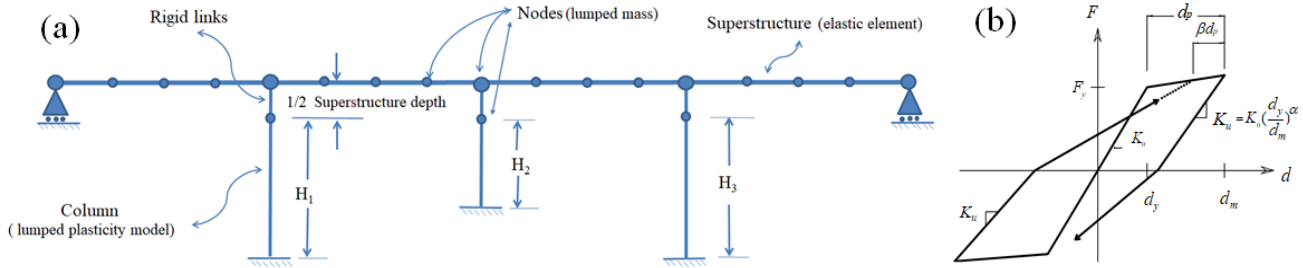
Figure 3. Structural modelling of the bridges: ( a ) Schematic presentation of the structural modelling of the bridge in the RUAUMOKO program (adapted from [34]) ( b ) Modified Takeda hysteresis loop (adapted from [45]).